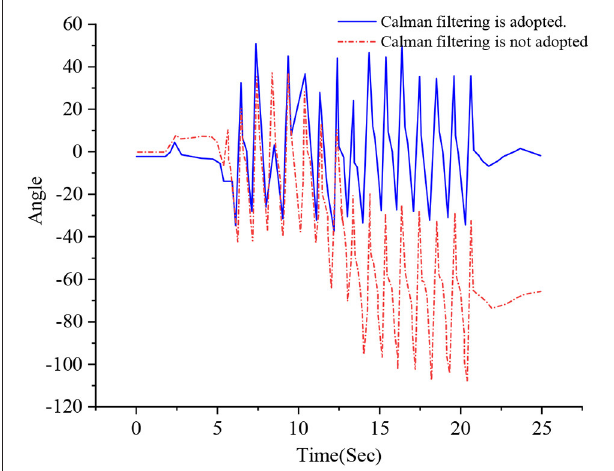
FIGURE 4 | A comparison of Kalman filtering effects of changing the walking